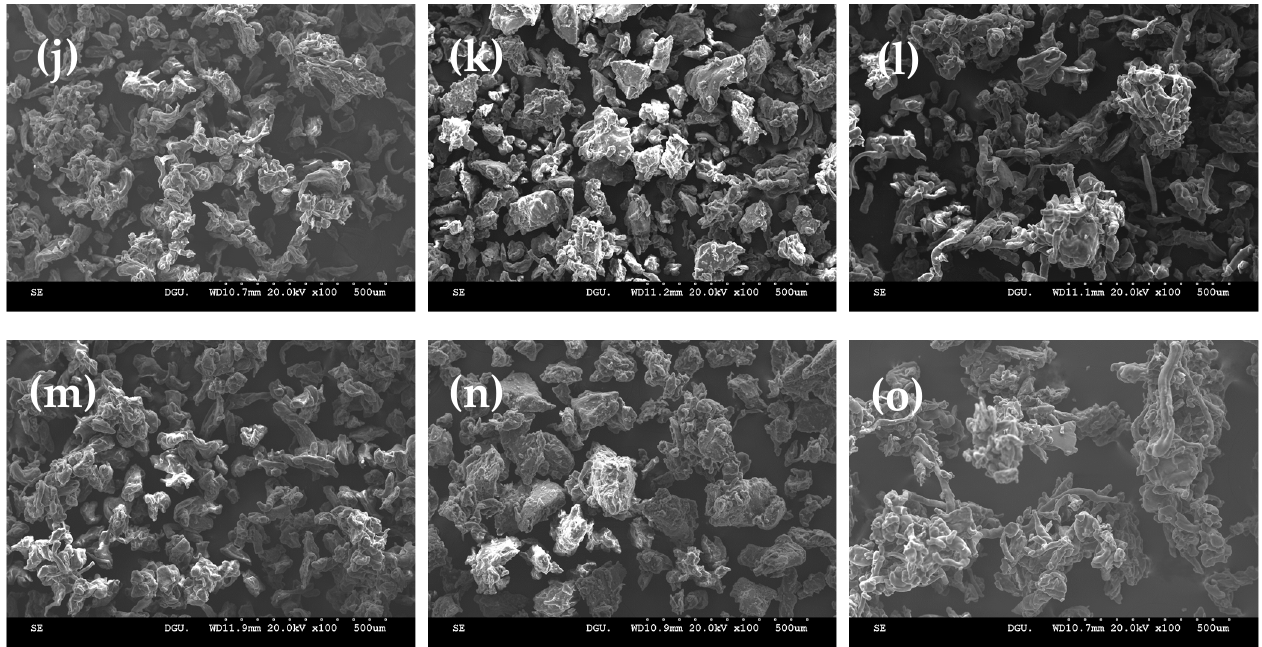
Figure 4. SEM micrograph for the fine gum powders ( a – c ) and gum agglomerates (GG, LBG, and CMC) with different sugar binders ( d – o ): ( d – f ) glucose, ( g – i ) sucrose, ( j – l ) lactose, and ( m – o ) sorbitol. Magnification 100 ×